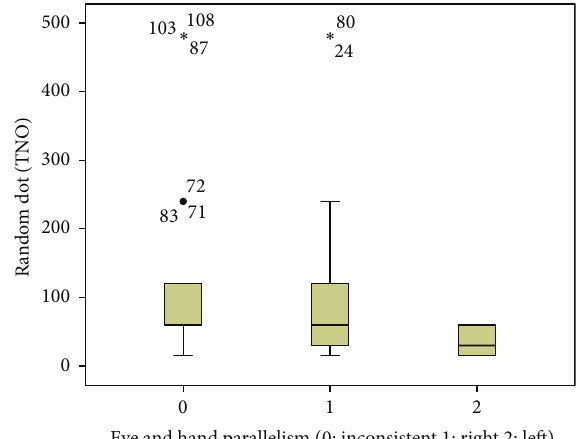
Figure 1: Stereopsis scores in TNO test according to the eye and hand parallelism ( 𝑃 < 0.01 , One-way ANOVA). Left-sided people have better stereopsis scores than right sided and inconsistent ones.